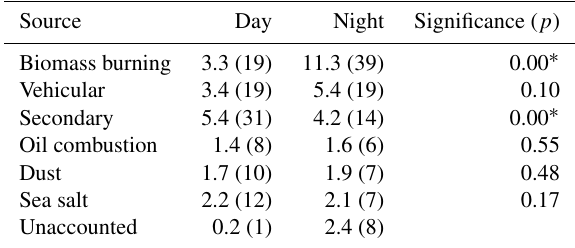
Table 3. Average day and night contributions of identified sources to PM 2 . 5 (µgm − 3 ). Respective percentages in parentheses. Statis- tical significance ( p ) refers to differences for day–night pairwise comparison assessed with Wilcoxon signed-rank non-parametric